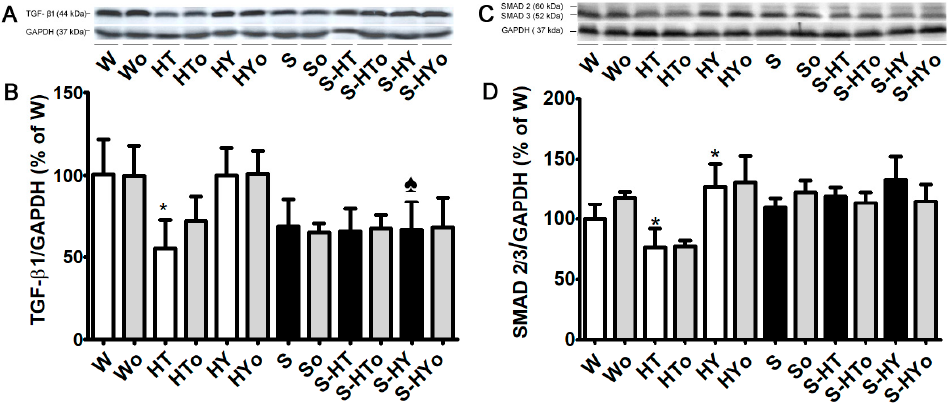
Figure 6. Protein levels of myocardial transforming growth factor β (TGF- β 1; A and B ) and